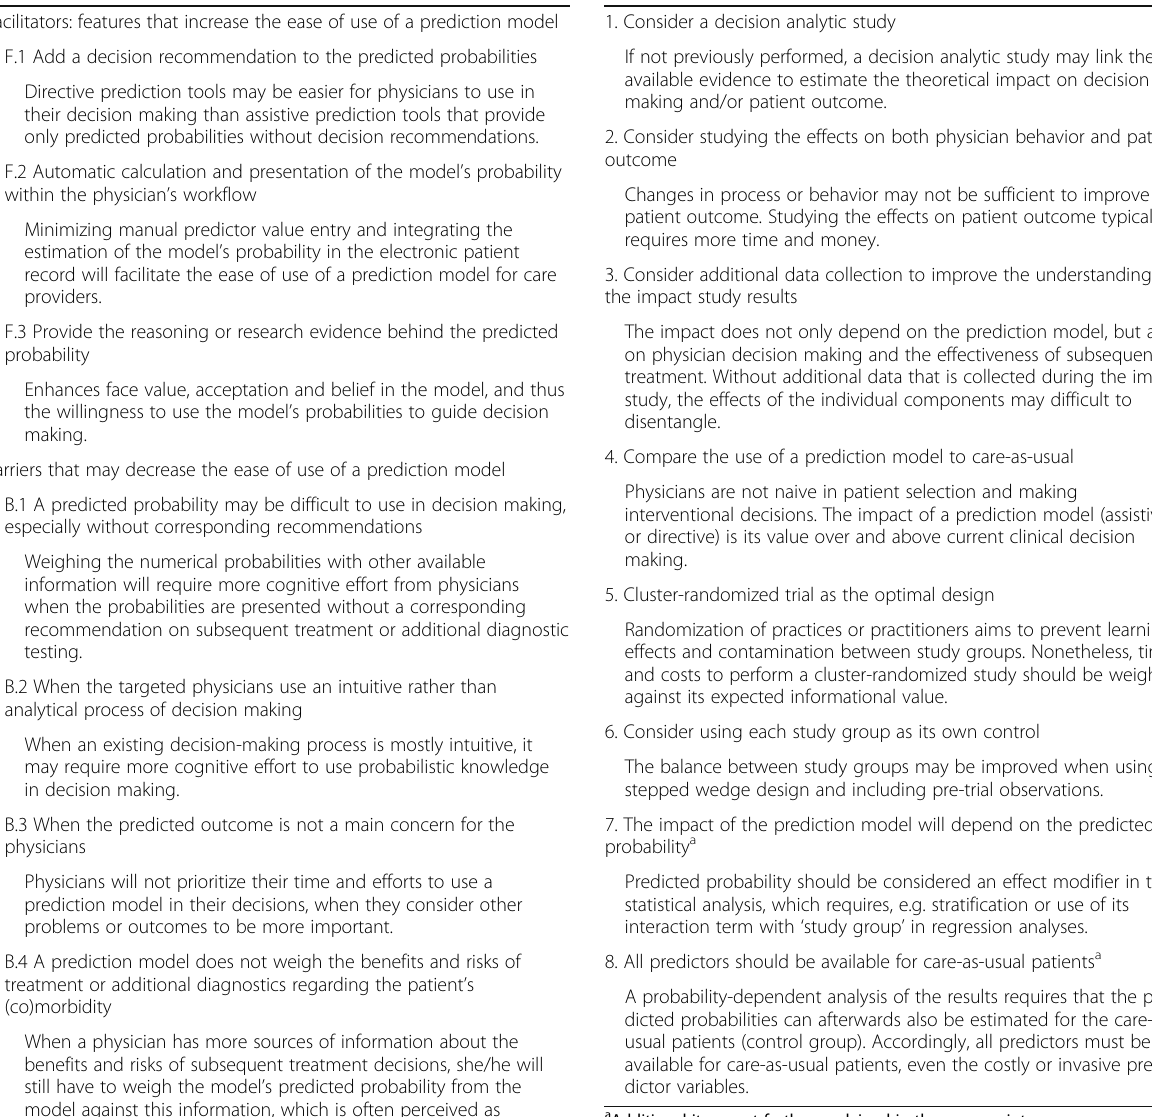
Table 4 Design of the impact study Table 3 How to present the model